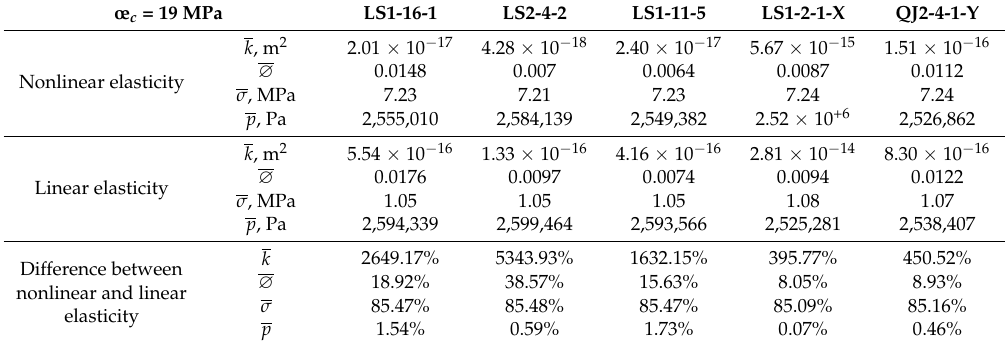
Table 6. Average property values for confining stress of 19 MPa and comparison with the linear elasticity